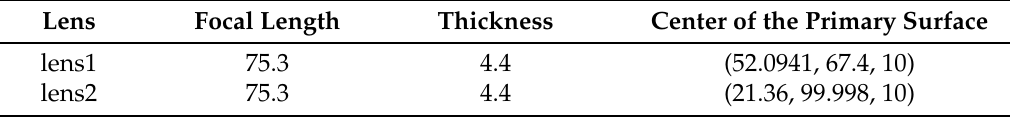
Table 5. Setup with lenses before BS2. All units in